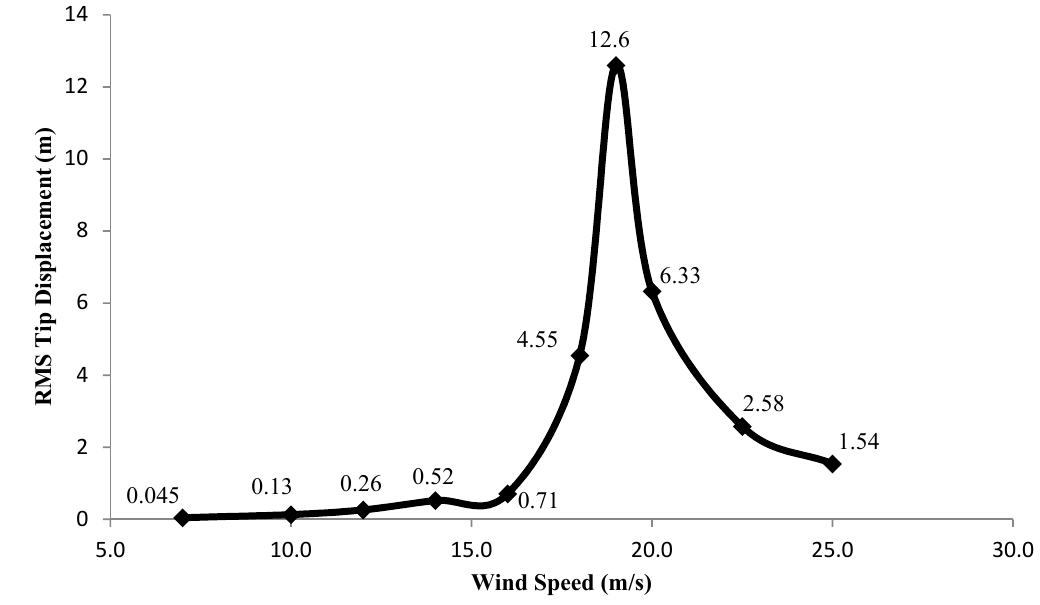
Figure 18. Graph of vibrational amplitude of the model vs wind speed.